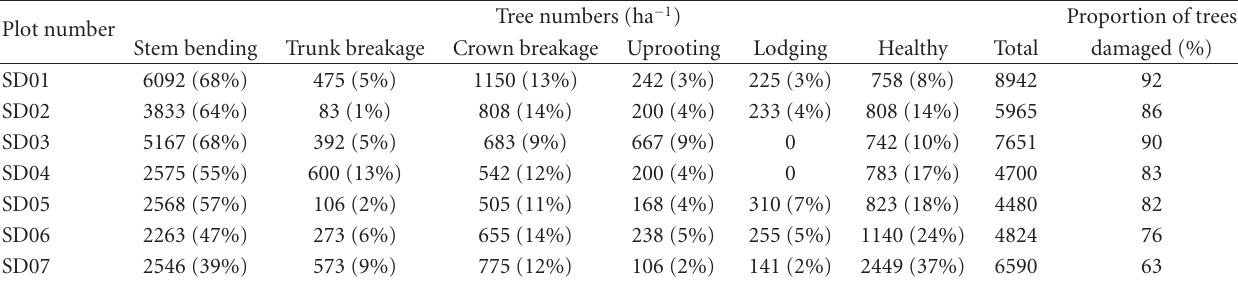
Table 2: Distribution of tree numbers according to the six categories of damage in the seven plots. Plot number